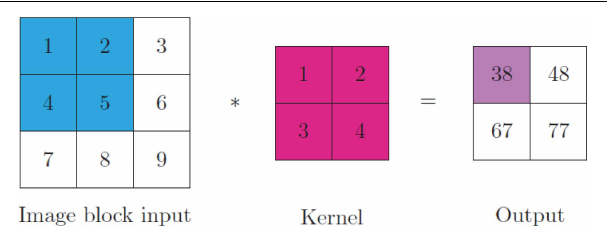
FIGURE 3 | The convolution operation (*) between an image input and a kernel. The element-wise product of the image block (blue) with the kernel (magenta) is calculated and added together (purple). All blocks are convolved with the kernel to generate an output of shape I h − K h + 1 , I w − K w + 1 .